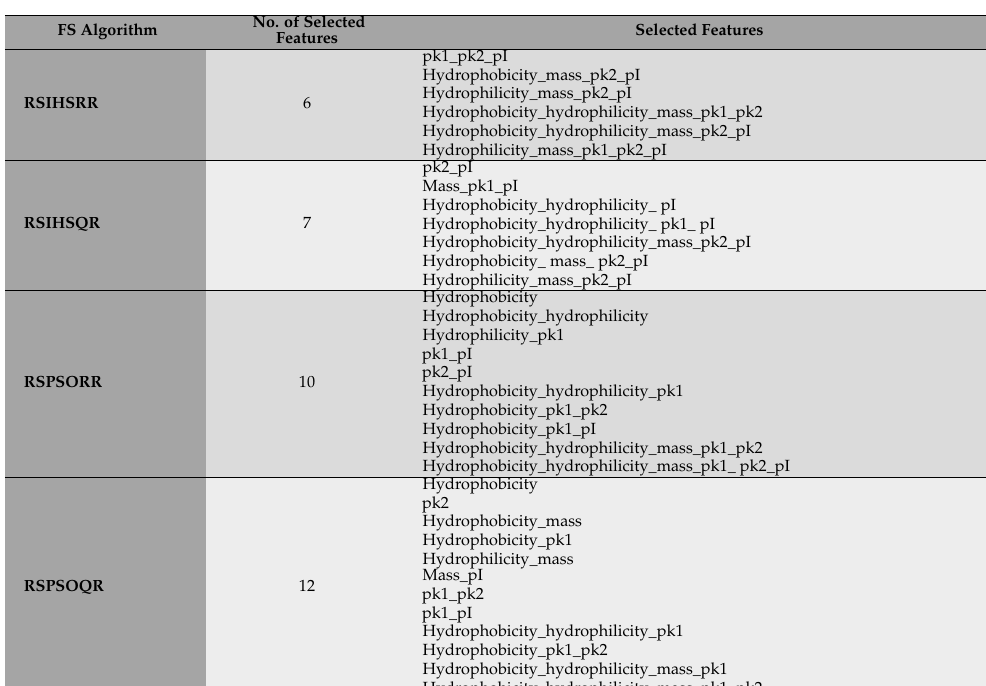
Table 2. Features Selected by FS algorithms.